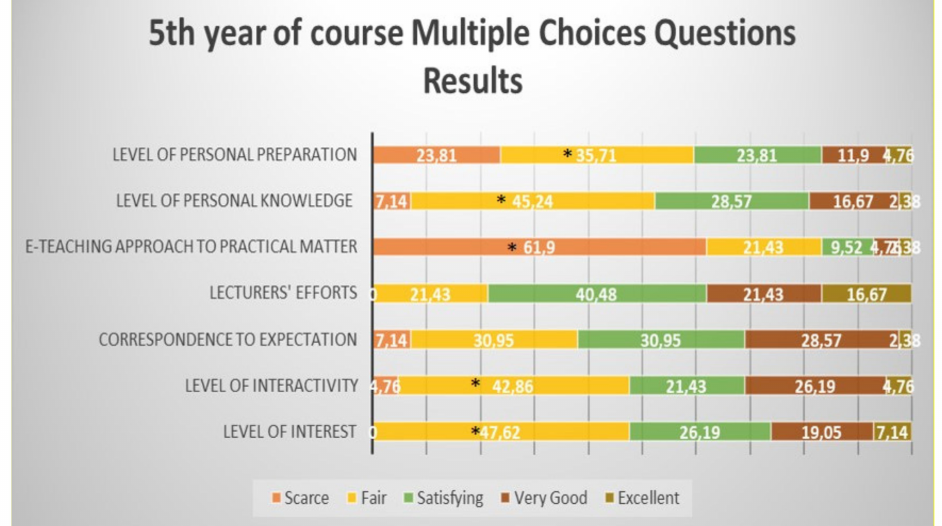
Figure 6. Questionnaire results for the fifth-year student feedback to the e-learning and e-teaching approach. The numbers in the bars indicate the percentages of the answers received ( n = 301). * p < 0.05 (Pearson’s chi-squared tests). Although the correspondence to expectations and the lecturers” efforts were mostly defined as “satisfying”, the differences did not reach statistical